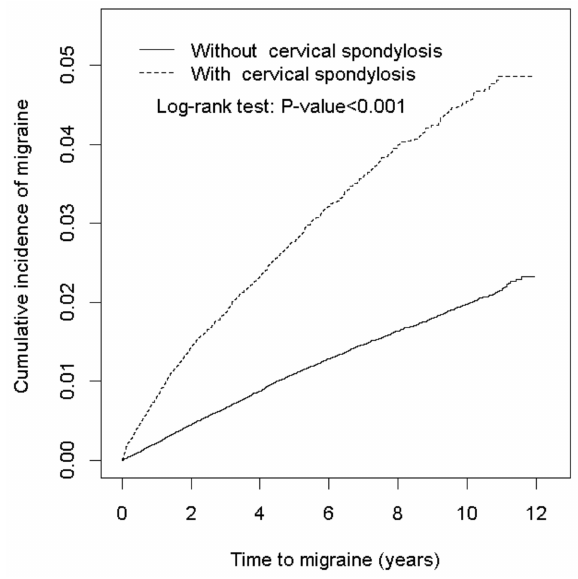
Figure 1. Cummulative incidence of migraine in individuals with and without cervical spondylosis (CS). Table 1. Comparisons of demographic characteristics and comorbidities in individuals with and without